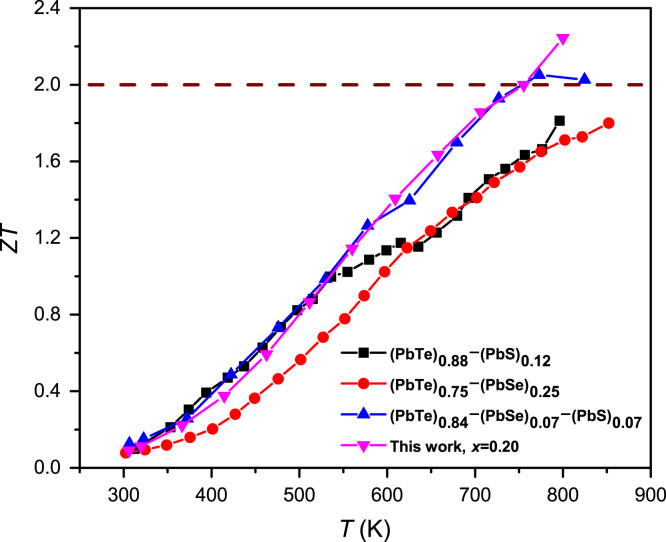
Dimensionless figure-of-merit ZT of (PbTe)0.75(PbSe)0.20(PbS)0.05 compounds comparing with (PbTe)0.88(PbS)0.12[2], (PbTe)0.75(PbSe)0.25[3], and (PbTe)0.86(PbSe)0.07(PbS)0.07[4].